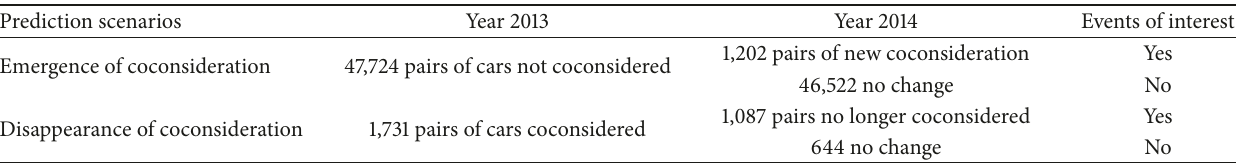
Table 7: Prediction scenarios of interest.